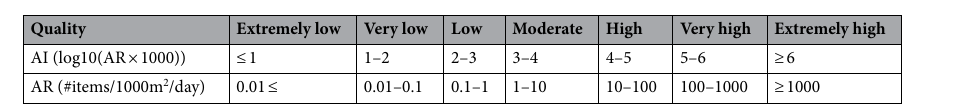
Table 1. Accumulation Index (AI), value and equivalence for the accumulation rates